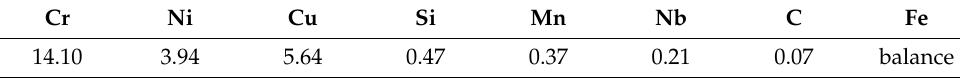
Table 1. Chemical components (wt. %) of the 17-4PH high-strength steel